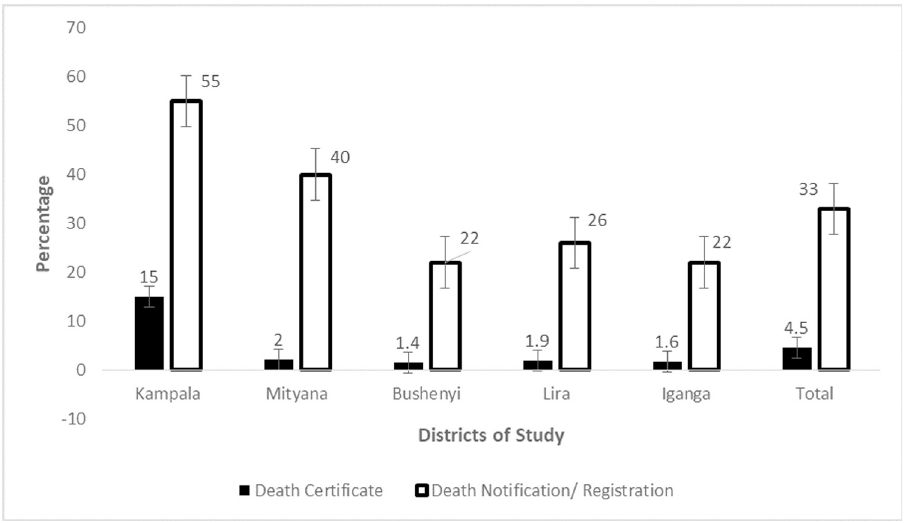
Fig 1. Prevalence of death certification and